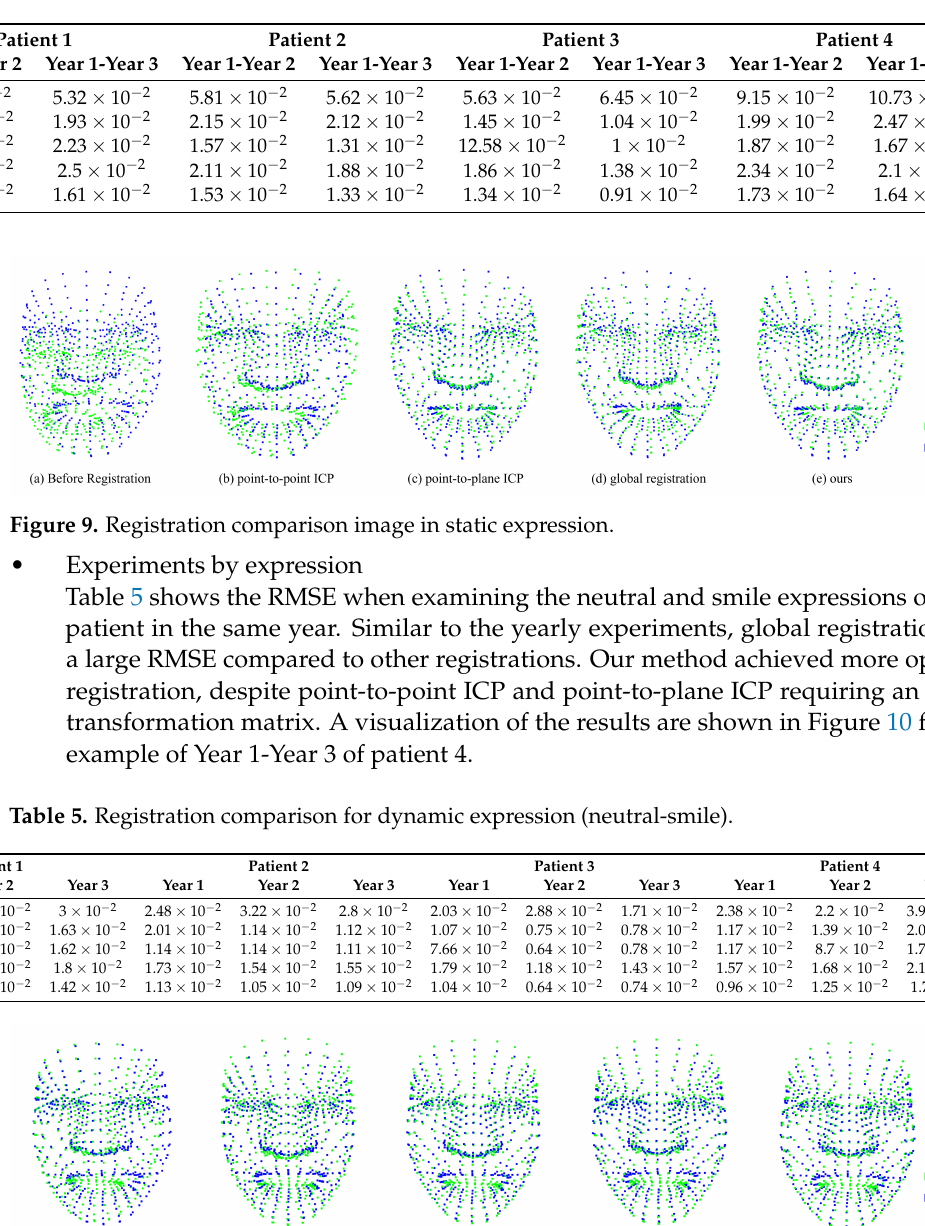
Table 4. Registration comparison in static expression.